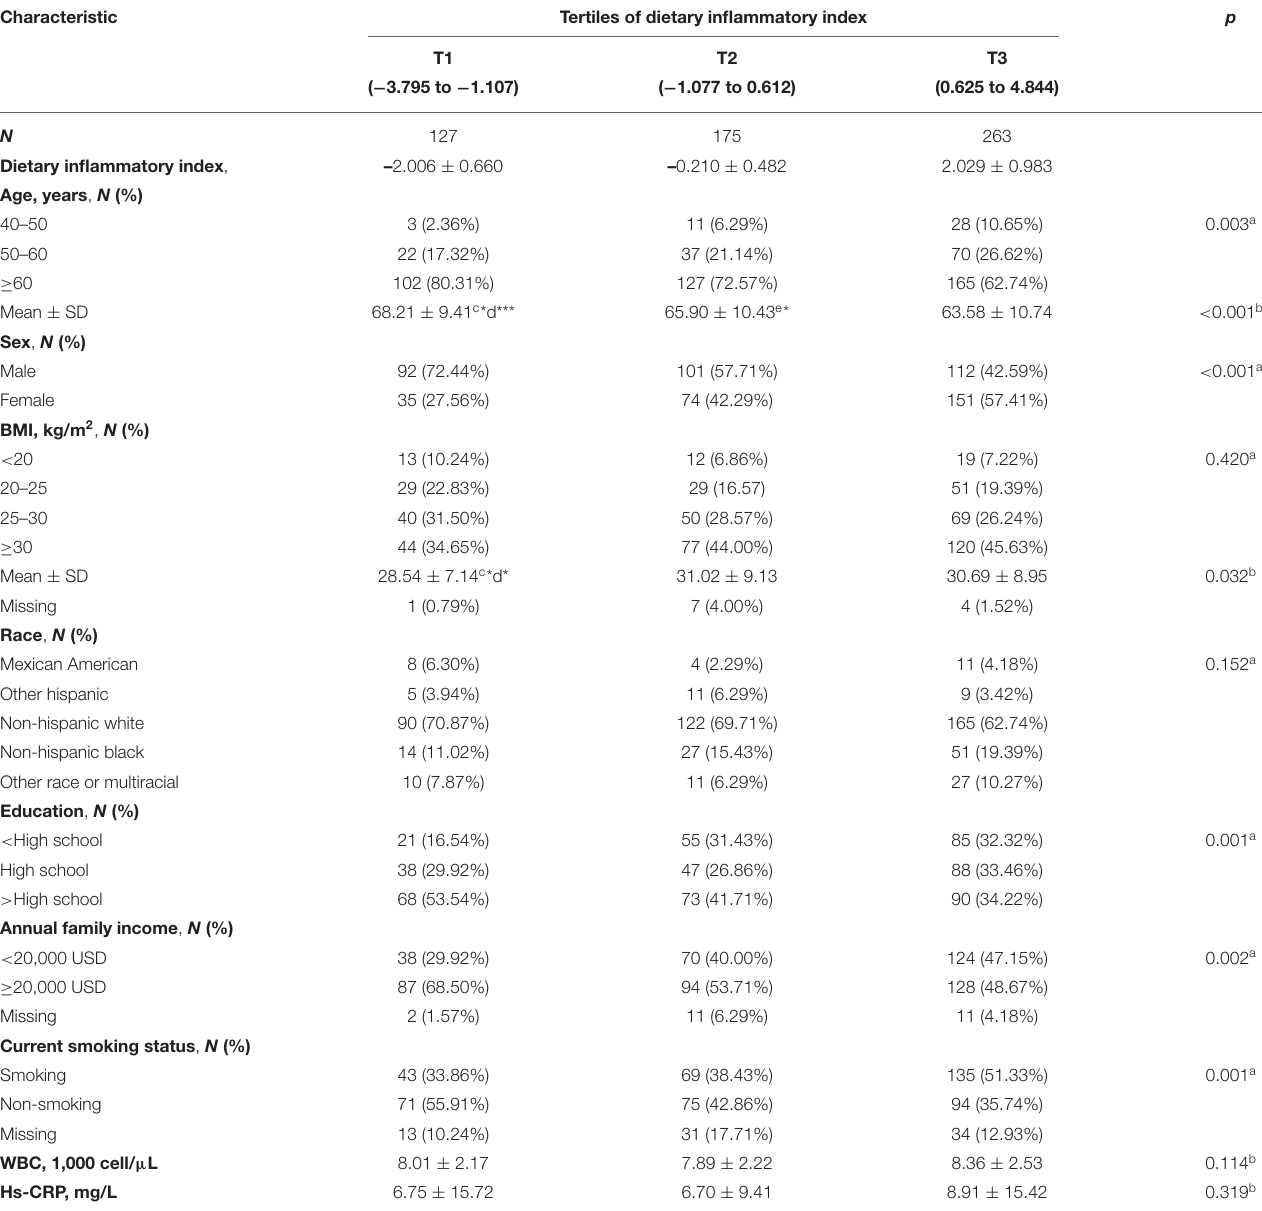
TABLE 2 | Characteristics of COPD participants aged 40 years and above by dietary inflammatory index (DII) tertiles. Characteristic Tertiles of dietary inflammatory